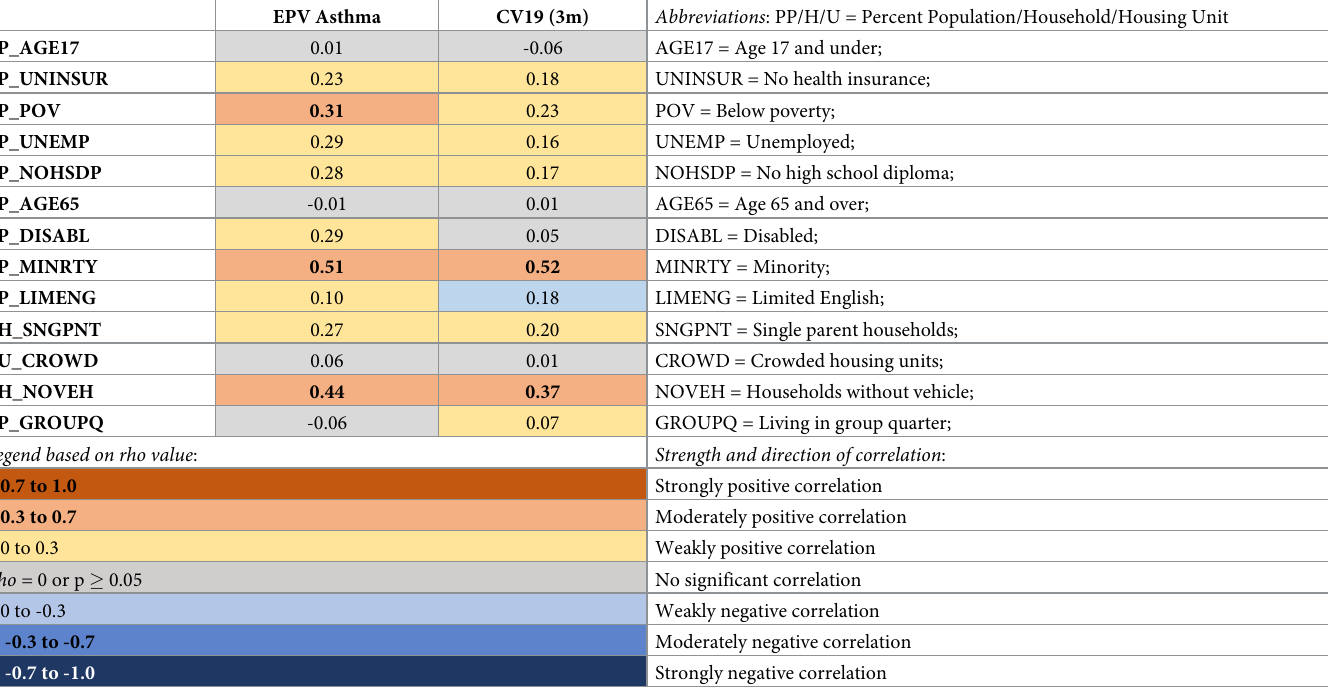
Table 3. Spearman’s rho (correlation coefficient) for specific social vulnerability factors, asthma and COVID-19. Statistically significant correlations were observed between several vulnerability factors and cumulative COVID-19 incidence up to June 2020 (CV19 [3m]) and/or estimated prevalence of asthma (EPV Asthma). However, the factors that showed moderately strong correlation coefficients with both health indicators were percent minority populations and percent households without a